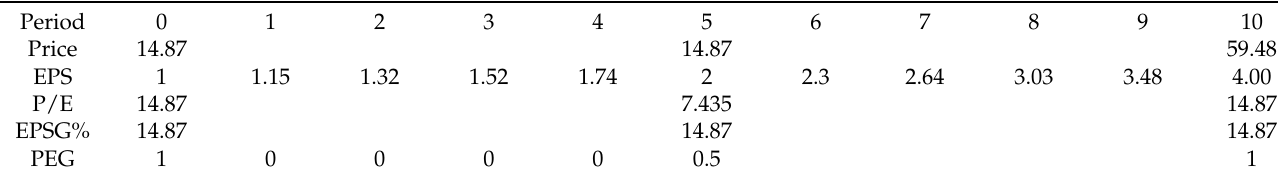
Table 3. Price Growth Over the Next 5 Years with 0% Price Growth in Previous 5 Years.